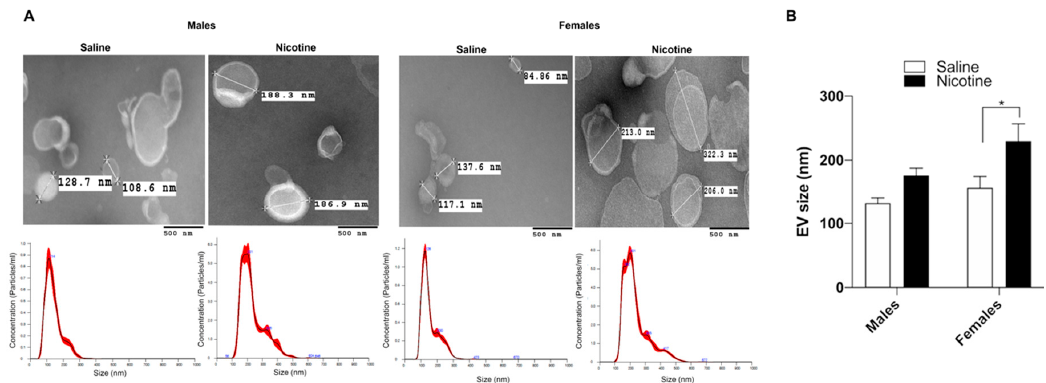
Figure 3. Characterization of BDEV. ( A ) BDEV isolated using a sucrose density gradient from the three groups were characterized using TEM that revealed increased sizes in both males and females which was larger in the latter post nicotine treatment. NTA analysis showing the different size distribution. ( B ) Average BDEV sizes. Average BDEV sizes for each group is represented as mean ± SEM, * p < 0.05 as determined by a 2-way ANOVA followed by Sidak’s multiple comparison test.